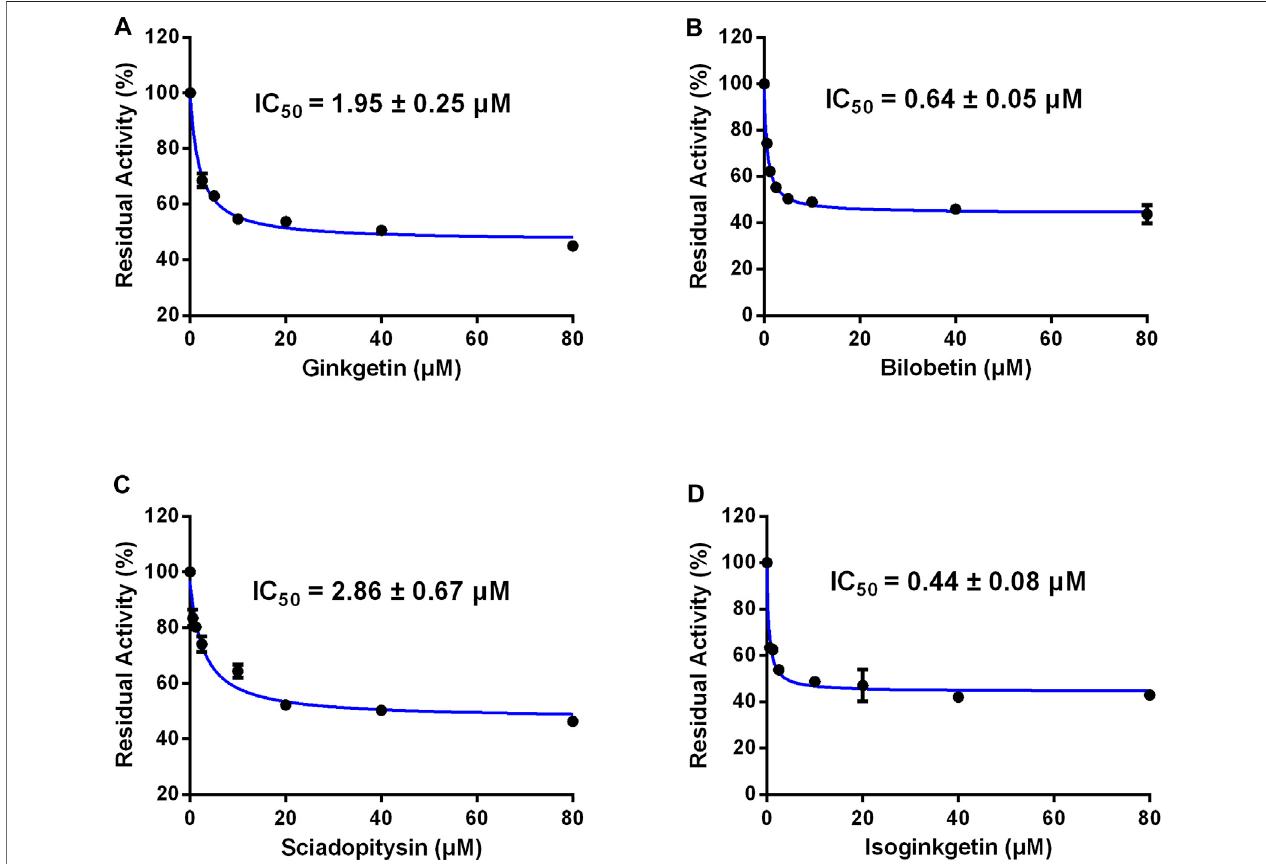
FIGURE4| Dose-inhibitioncurves ofginkgetin (A) , bilobetin (B) , sciadopitysin (C) and isoginkgetin (D) on CES2 usingCPT-11 astheprobe substrate inHLMs. All data were shown as mean ± SD of triplicate assays.